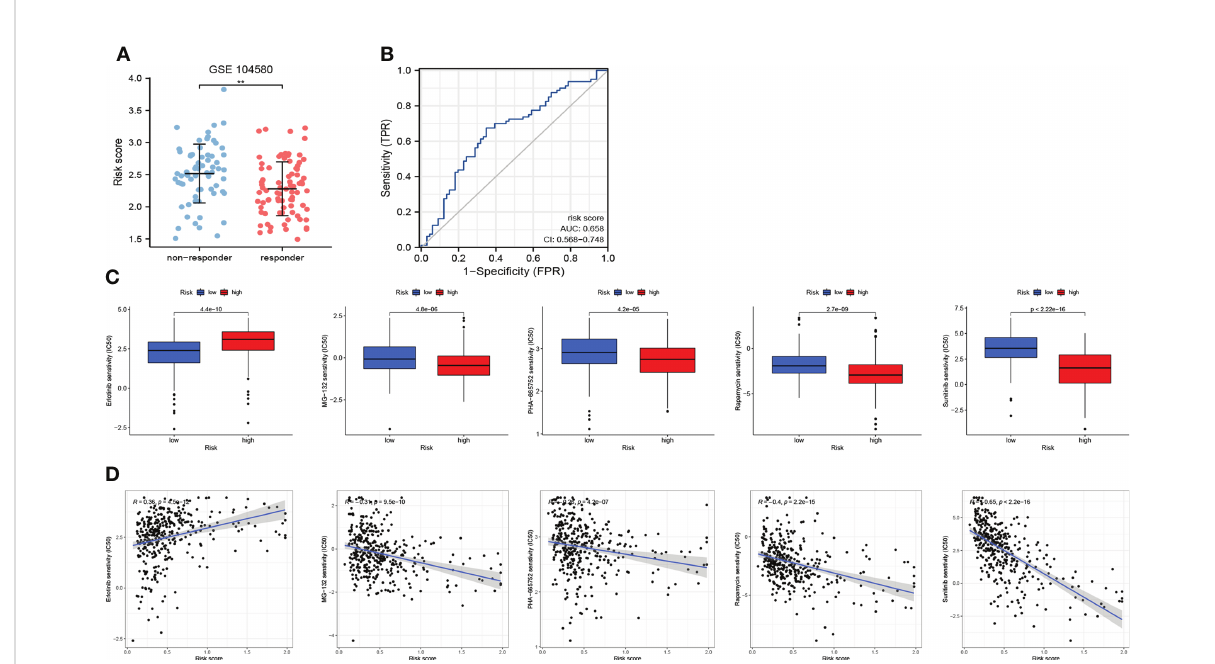
FIGURE 10 The role of CRFs in drug sensitivity and responses to transcatheter arterial chemoembolization (TACE). (A) Comparison of the risk score in responders and non-responders to TACE in GSE140580. (B) ROC curve of the risk score in determining the responses to TACE. (C) Comparison of drug sensitivity in high- and low-risk groups. (D) The correlation of risk scores and drug